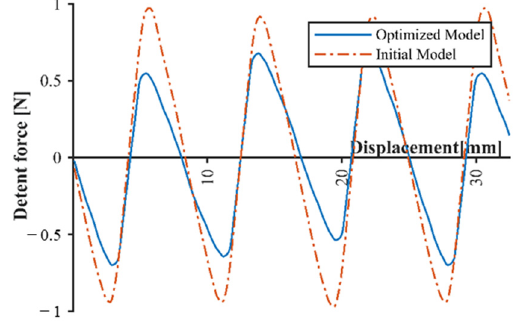
Figure 12. Detent force by slot effect of initial model and optimized model.